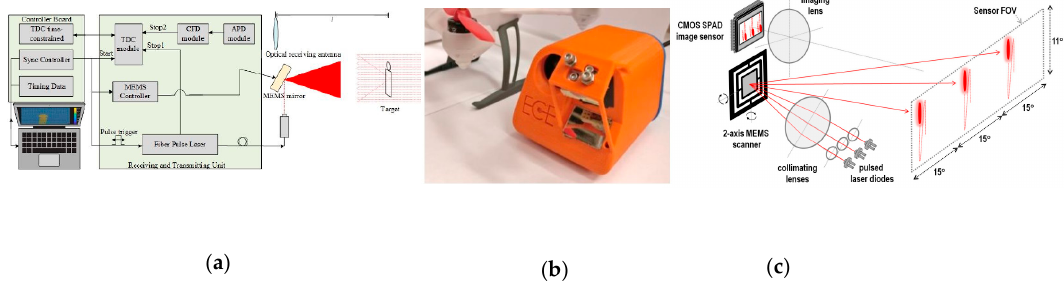
Figure 9. 2D MEMS LiDAR systems built with ( a ) an electrostatic MEMS mirror and a single pixel receiver [74] ( b ) an electrothermal MEMS mirrors with a single pixel receiver [75]; ( c ) an electromagnetic MEMS mirror with a detector array [76].